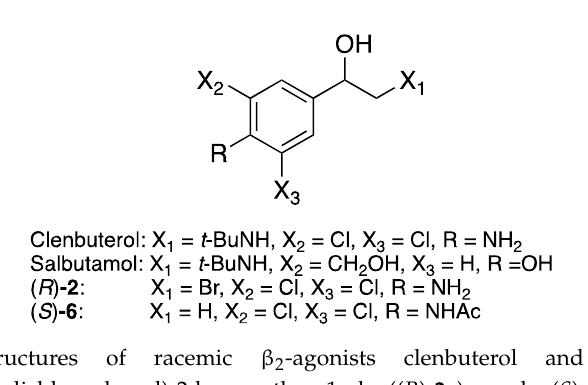
Figure 1. Structures of racemic β 2 -agonists clenbuterol and salbutamol and ( R )-1-(4-amino-3,5- dichlorophenyl)-2-bromoethan-1-ol (( R )- 2a ) and ( S )- N -(2,6-dichloro-4-(1- hydroxyethyl)phenyl)acetamide (( S )- 6a ).